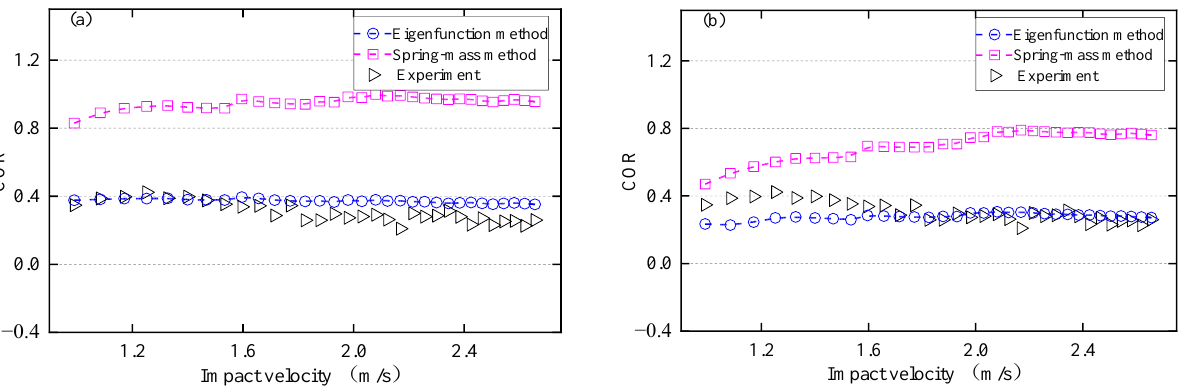
Figure 14. Comparison of coefficient of restitution (COR): ( a ) Stronge model; ( b ) Thornton model.